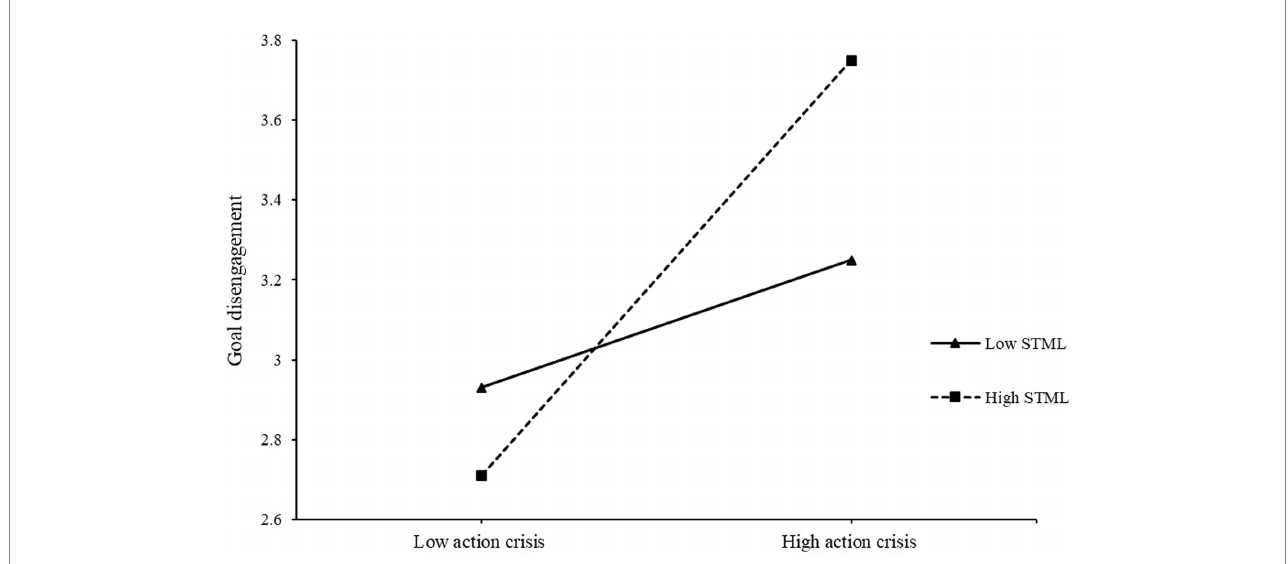
FIGURE 4 Effects of action crisis and self-transcendence meaning of life on goal disengagement in Study 2. STML, self-transcendence meaning of